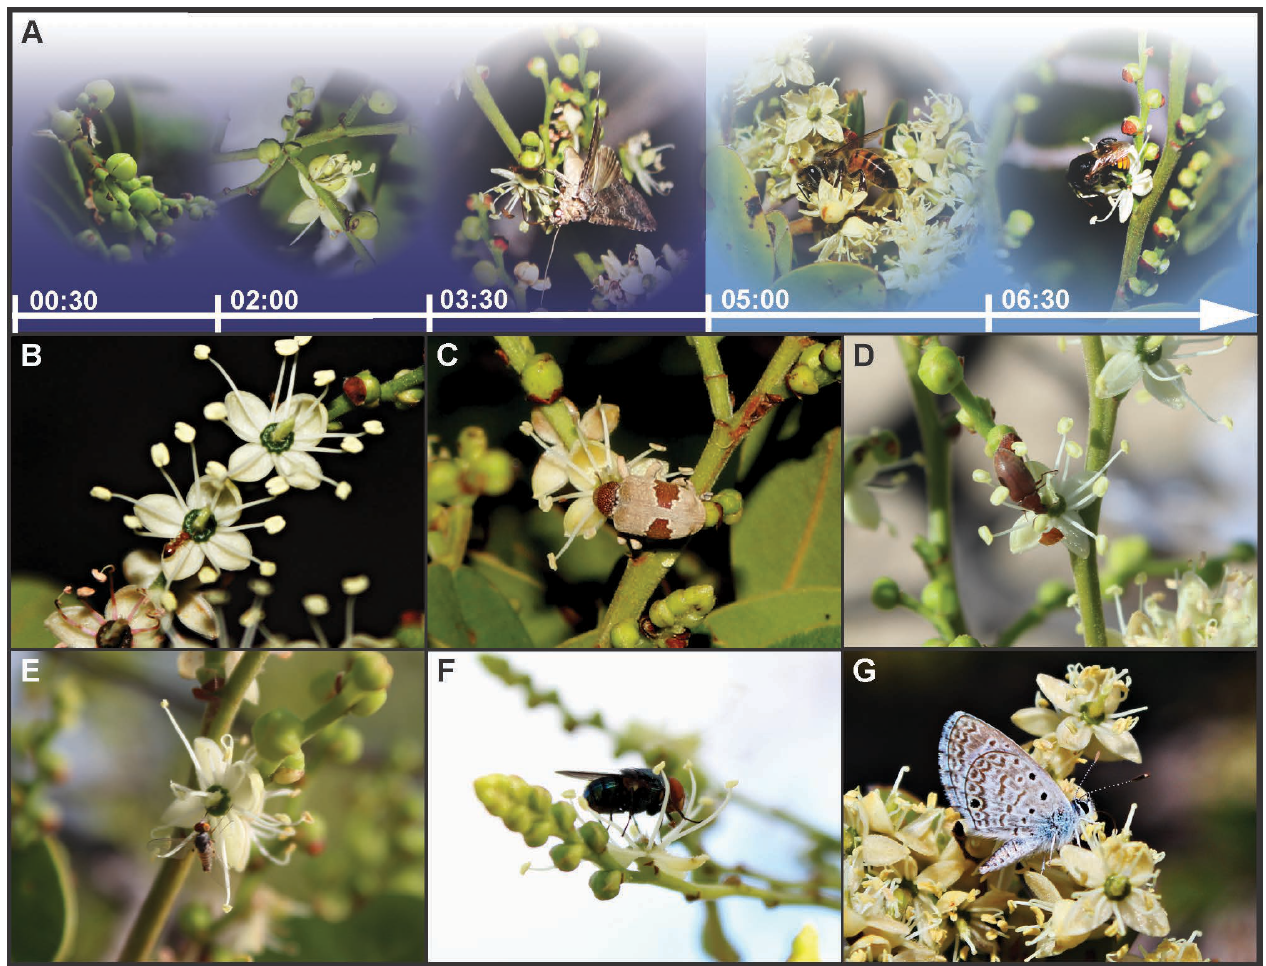
Figure 3 – Anthesis and floral visitors of Copaifera coriacea . A . Development of anthesis and the activities of moths and bees classified as effective pollinators. B–G . Floral visitors and pollinators searching for nectar. Ants ( B ), beetles ( Rhinochenus cf. stigma , C ; undeterminated species, D ), and dipterans ( E , F ), classified as thieves, and Leptotes cassius , classified as a potential pollinator ( G